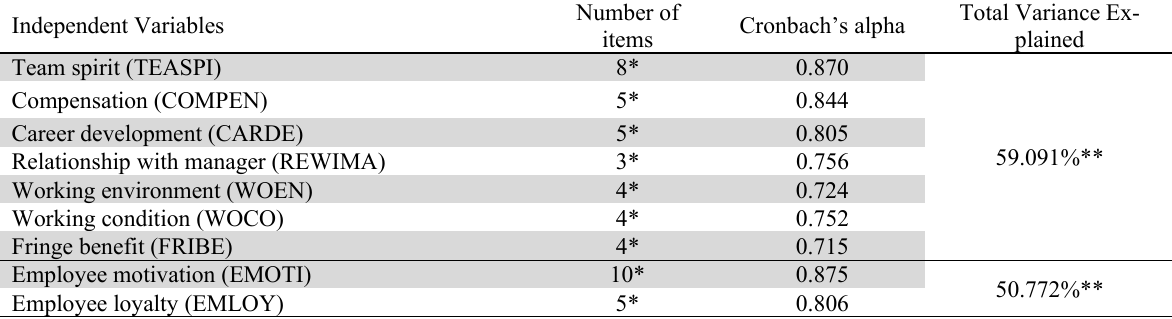
Reliability and validity of measurement scale Independent